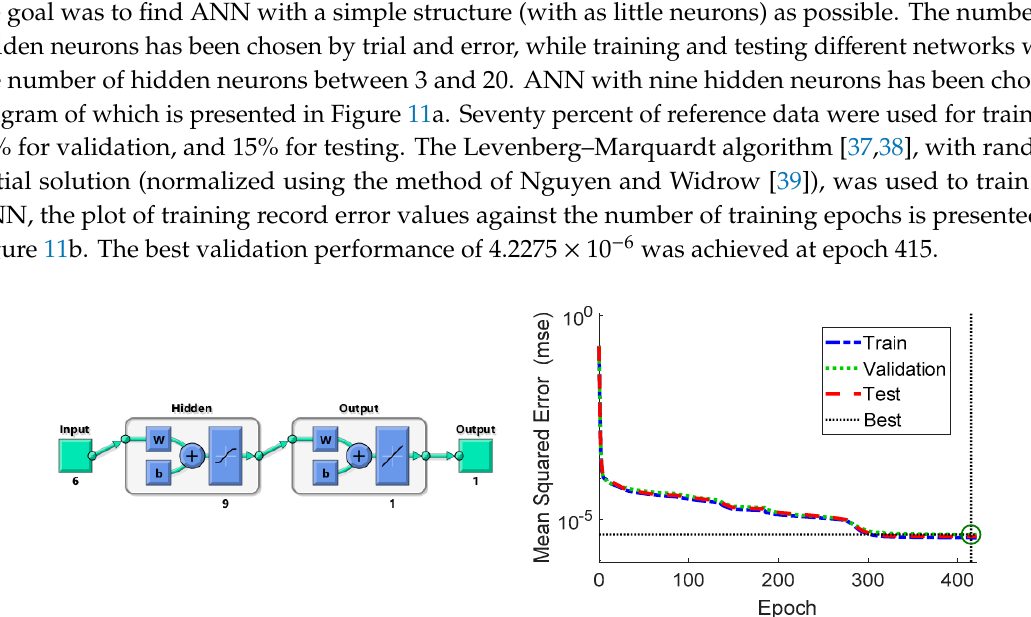
Figure 11. Trained artificial neural network (ANN): ( a ) architecture and ( b ) training performance.